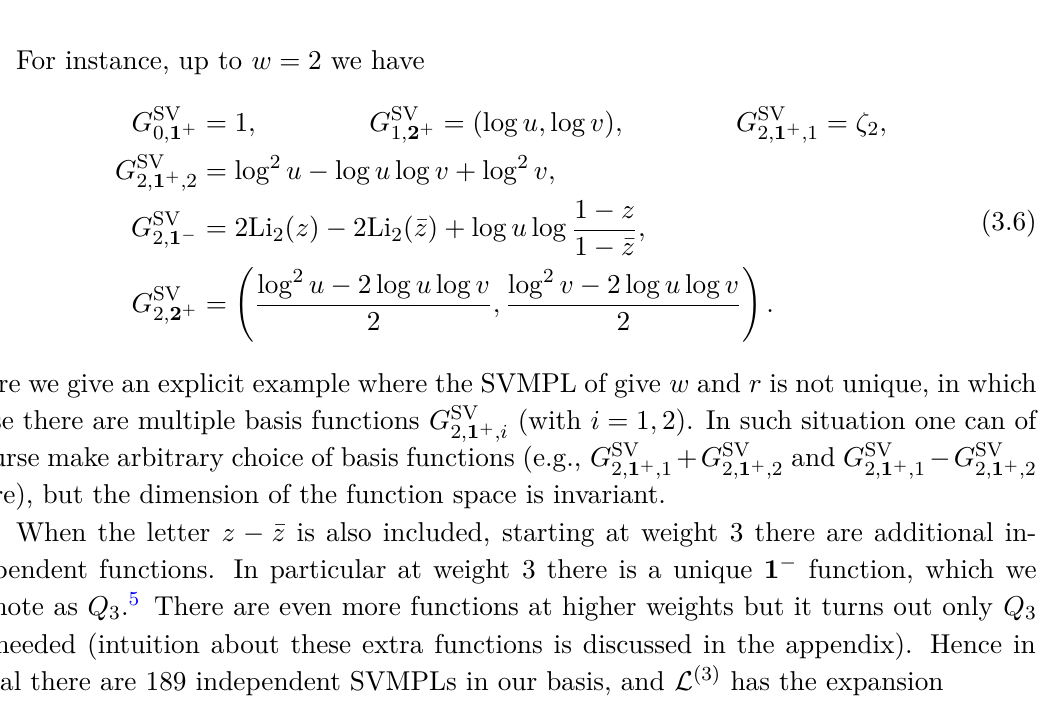
Table 1 . Number of independent SVMPL functions with fixed weight w and fixed S 3 × Z 2 repre- sentation, without considering symbol letter z − ¯ z